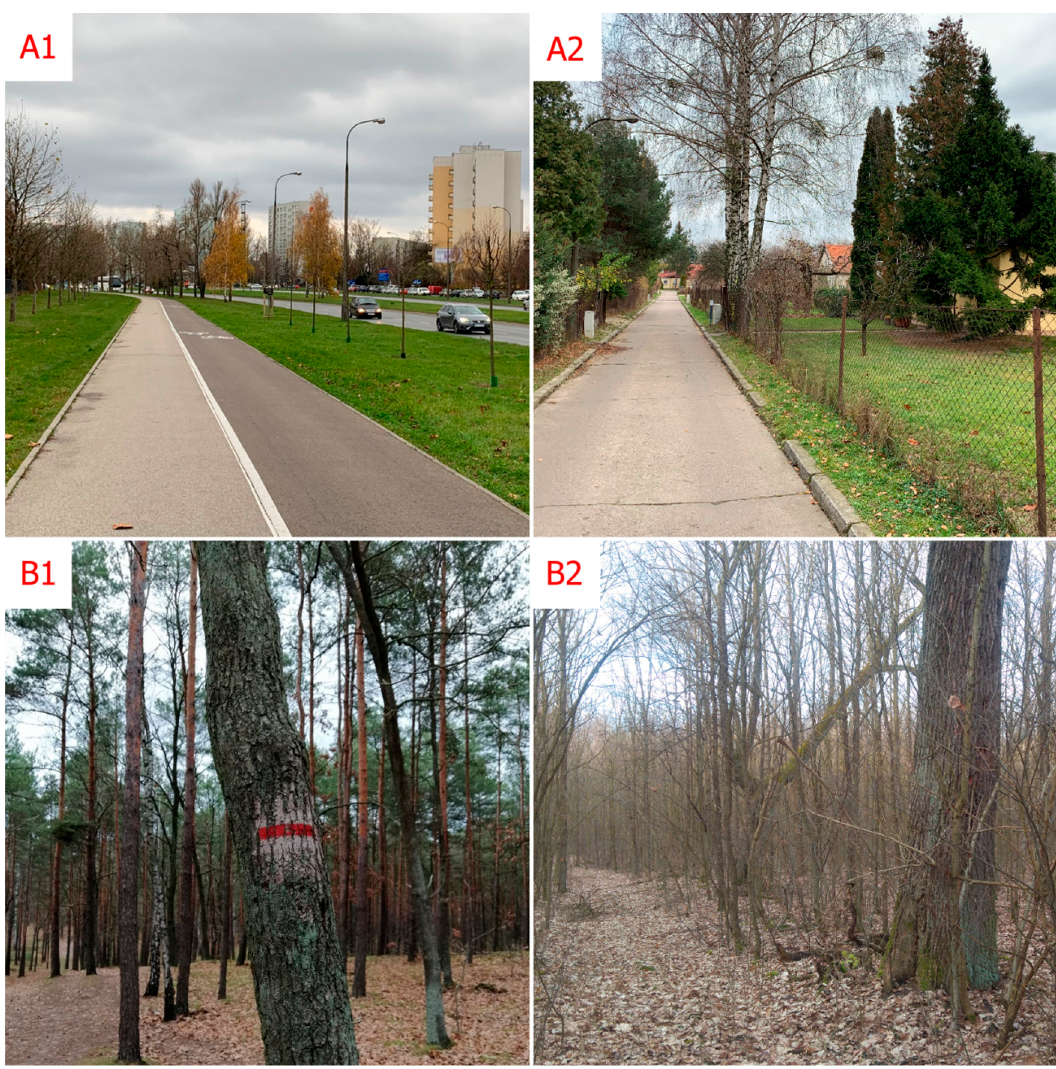
Figure 2. Photos: ( A1 ) apartment suburbs, ( A2 ) green suburbs, ( B1 ) coniferous forest, ( B2 ) deciduous Figure2. Photos: ( A1 )apartmentsuburbs,( A2 )greensuburbs,( B1 )coniferousforest,( B2 forest.